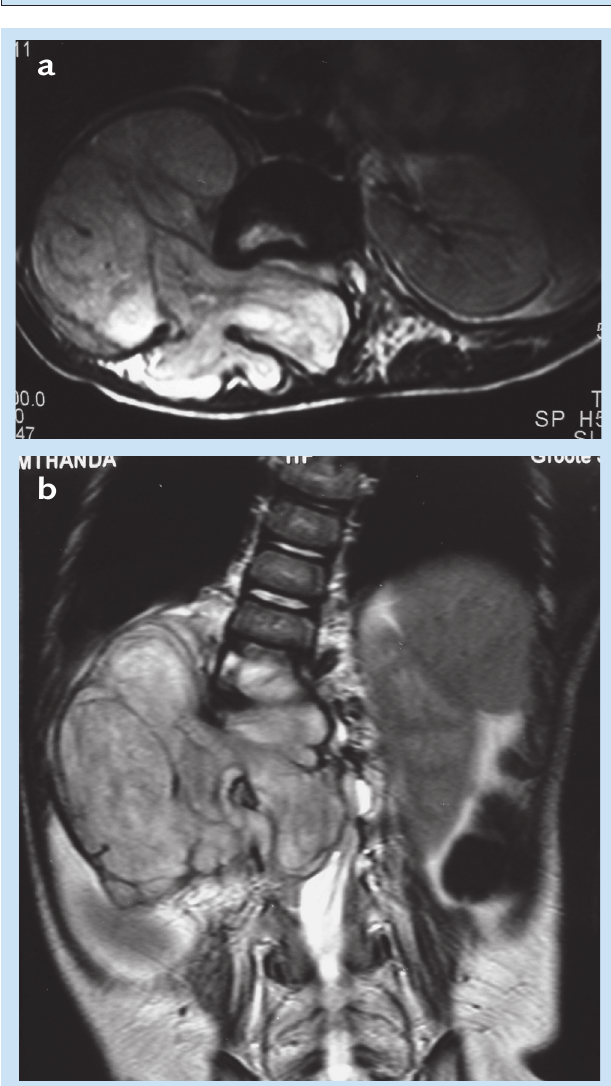
Fig. 3. A one-and-a-half-year-old boy with infantile fibromatosis. Axial (a) and coronal (b) T2-weighted studies show a hyperintense mass with extra- dural extension via the neural foramina.